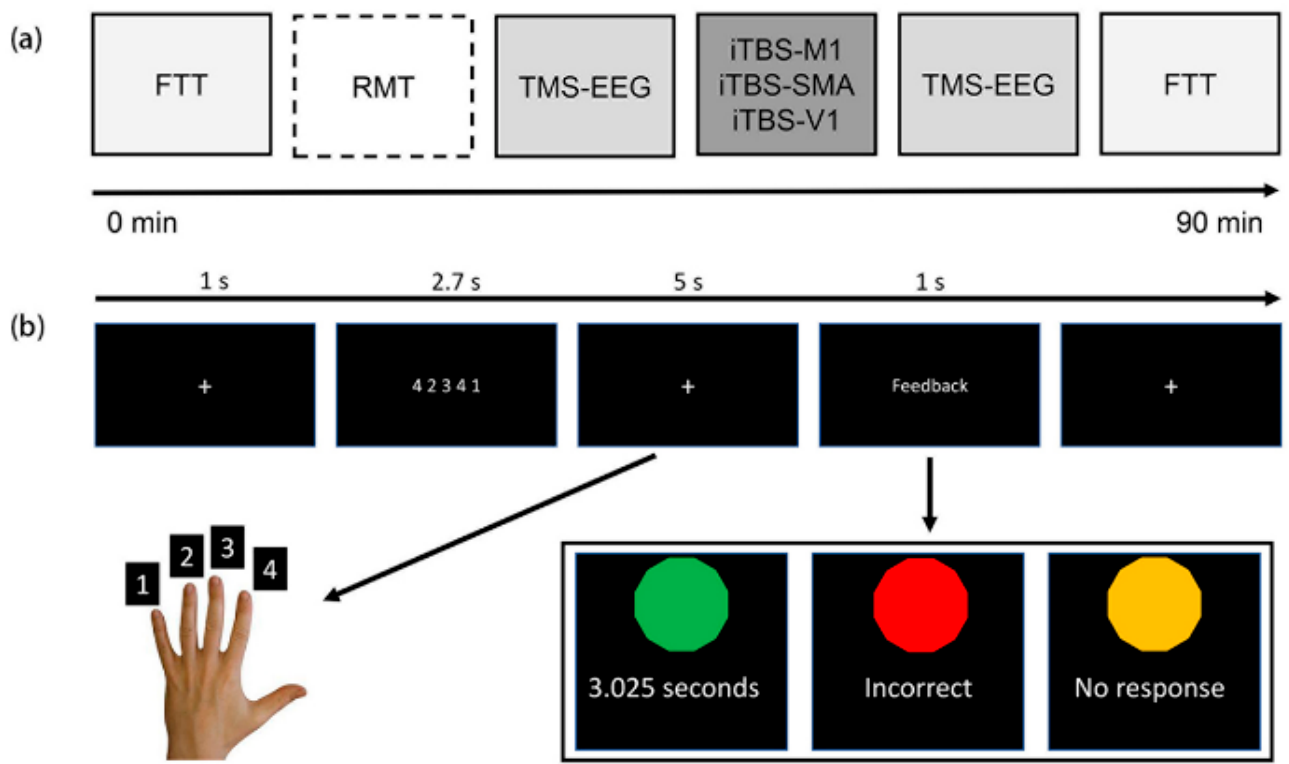
Figure 1. Experimental procedures and the finger tapping task. ( a ) TMS-EEG recording of 90 single-pulse of SMA and V1. Resting motor threshold was determined in the first session only and the stimulation intensity was maintained the same for the conditions that followed. ( b ) Illustration of the finger tapping task (only the left hand is shown). FTT: finger tapping task; RMT: resting motor threshold; TMS-EEG: transcranial magnetic stimulation and electroencephalography; iTBS: intermittent theta burst stimulation; M1: primary motor cortex; SMA: supplementary motor area; V1: primary visual cortex.